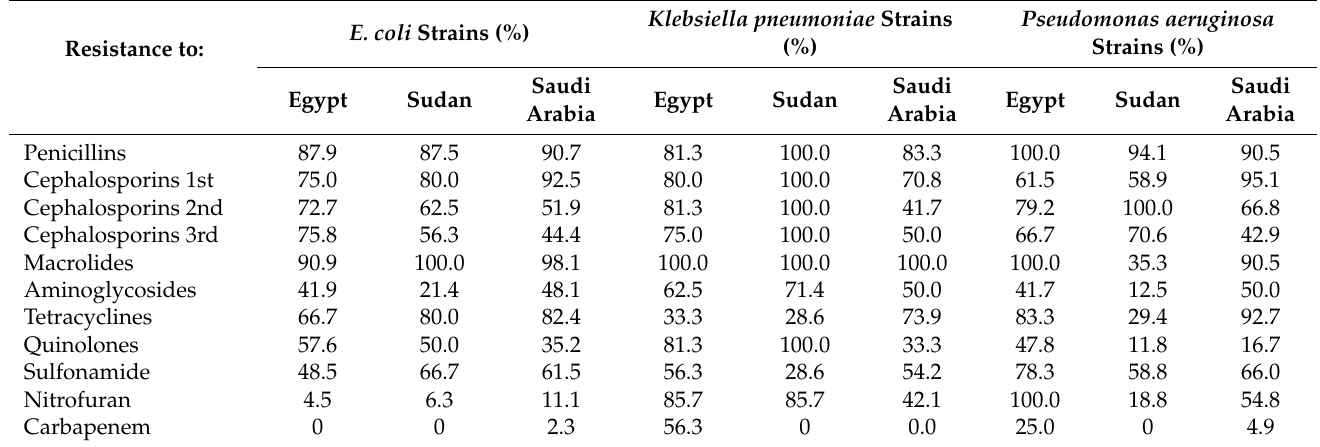
Table 2. Summary of the patterns of resistance to antibiotic classes for Escherichia coli , Pseudomonas aeruginosa , and Klebsiella pneumoniae strains obtained from three different